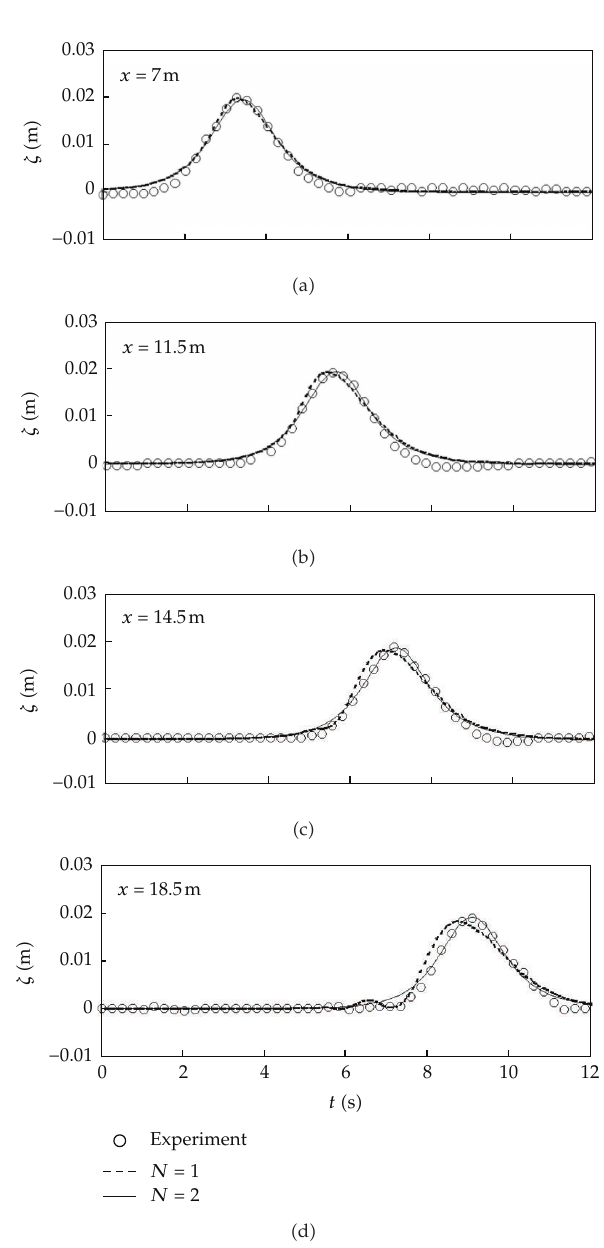
Figure 5: Surface displacements ζ at each point in one of the experimental cases by Sakai et al. (cid:5) 3 (cid:6) . The still water depth and incident wave height are 0.4m and 0.02m, respectively. The flexural rigidity of thin plate is 450.0Nm 2 . In the computation, the number of terms for velocity potential, N , is one or two.